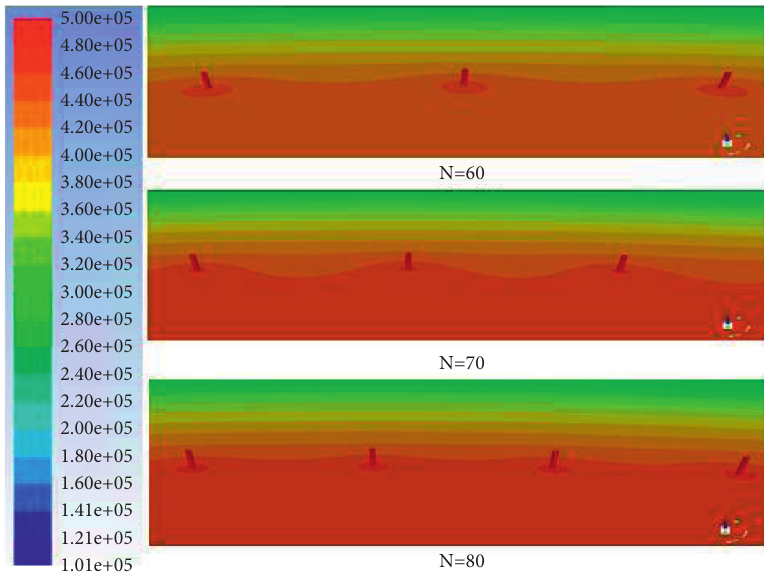
Figure 8: Air film pressure distribution of bearings with different number of orifices ( p � 0 . 05 MPa, d � 0.05mm, h � 7mm).